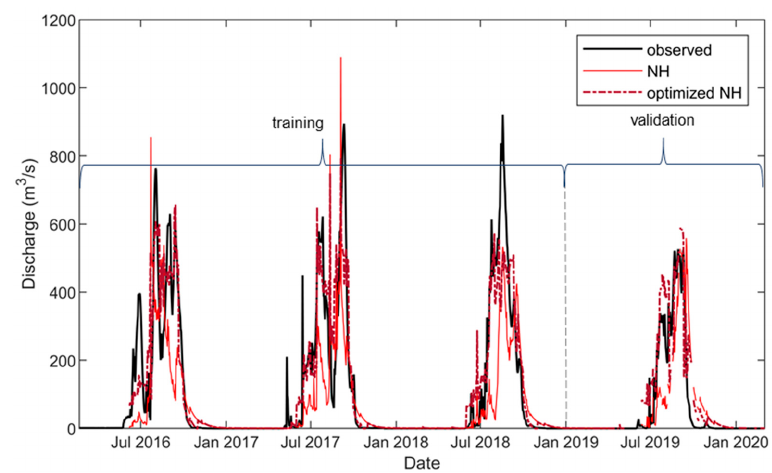
Figure 5. Hydrograph of original and optimized 5-day Niger HYPE forecasts (5-day lead time series) at Garbey Kourou for training years (2016–2018) and validation year (2019).